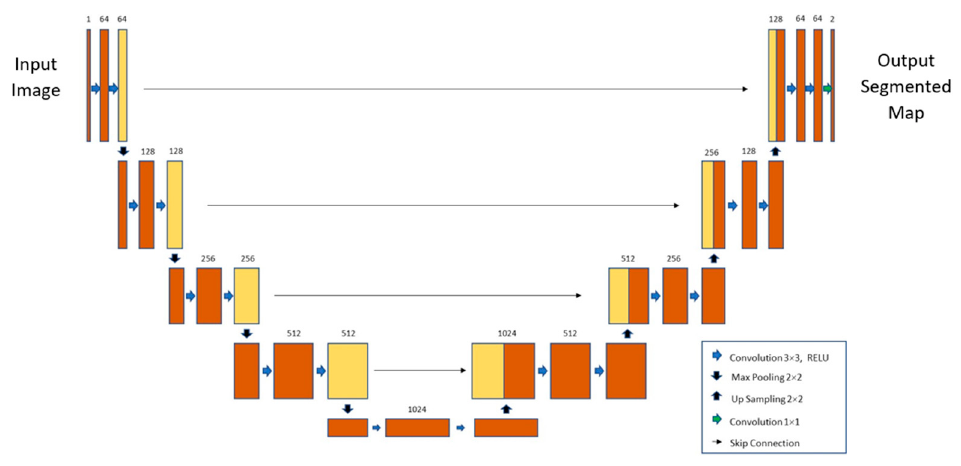
Figure 5. U-net model structure